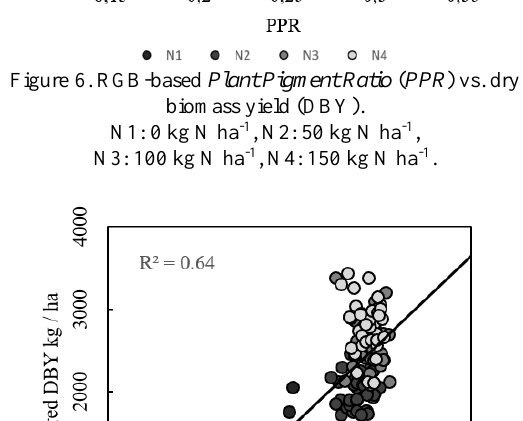
Figure 4. Detailed view of Micasense RedEdge-M based NDVI map.